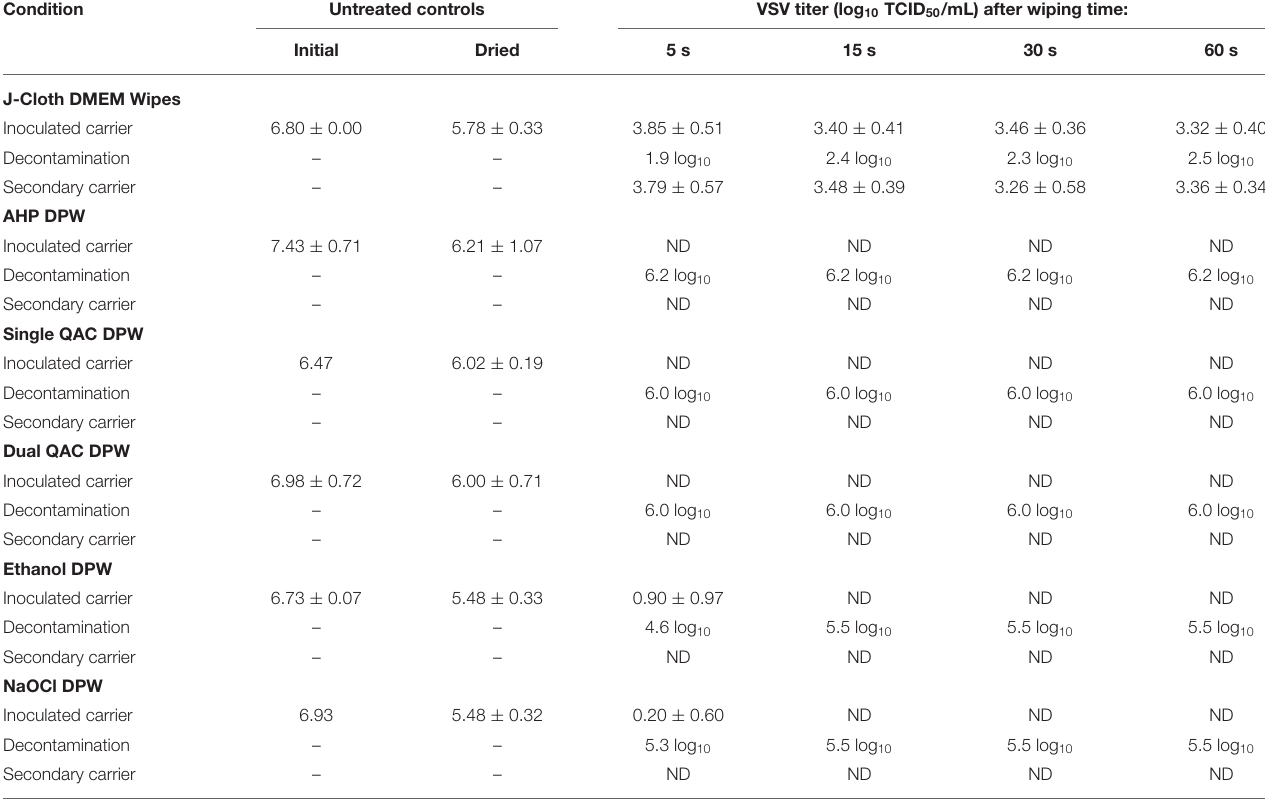
TABLE 3 | Efficacy of DPW vs. DMEM-impregnated J-Cloth wipes for removal/inactivation (decontamination) or transfer of vesicular stomatitis virus (VSV) * .